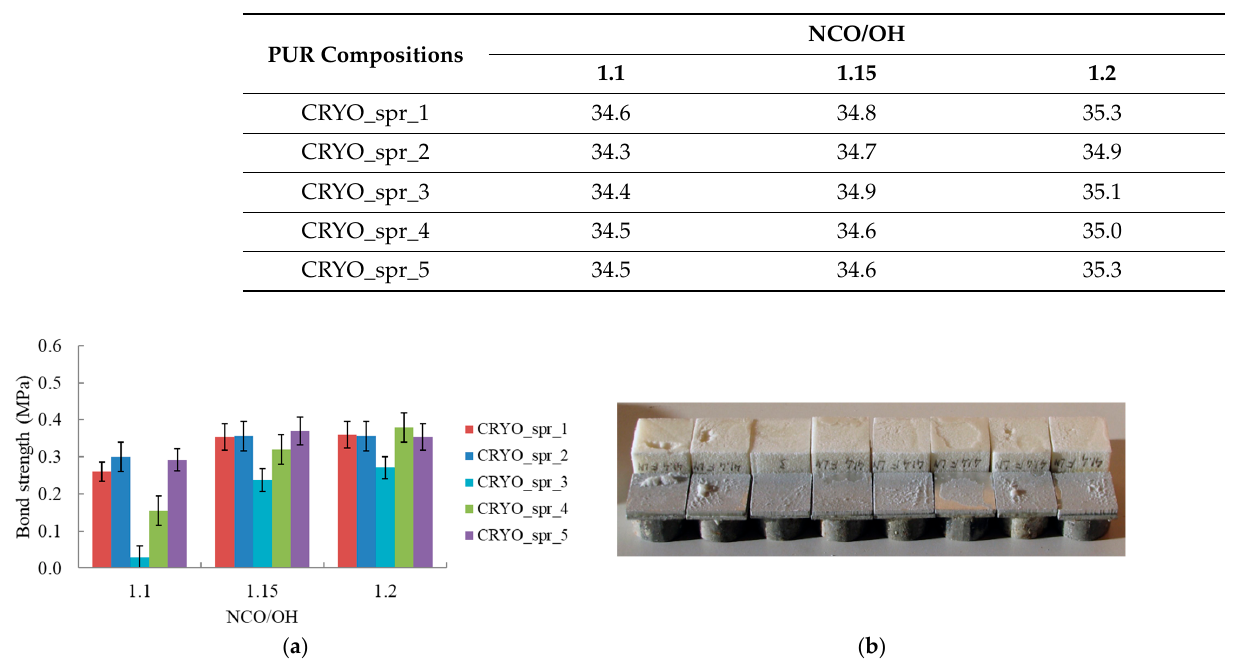
Table 5. Apparent densities (kg/m 3 ) of spraying PUR compositions.